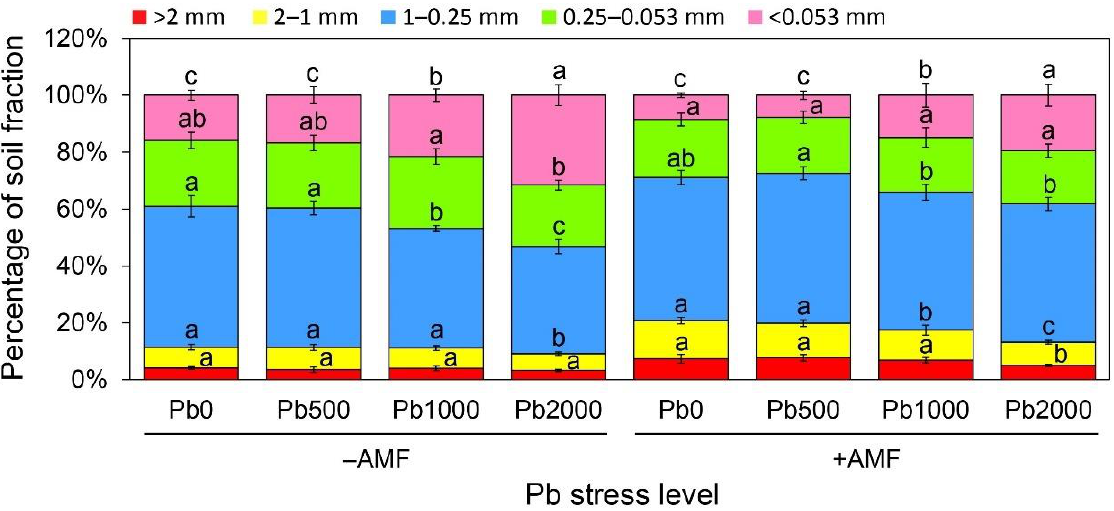
Figure 4. Soil-aggregate distribution under different treatments. Non-AMF inoculation ( − AMF); AMF inoculation (+AMF); Pb stress level (0, 500, 1000, and 2000 mg kg − 1 ). Data represent mean ± SD for biological replicates ( n = 6). The same letter indicates no significant difference (Duncan’s test, p < 0.05).